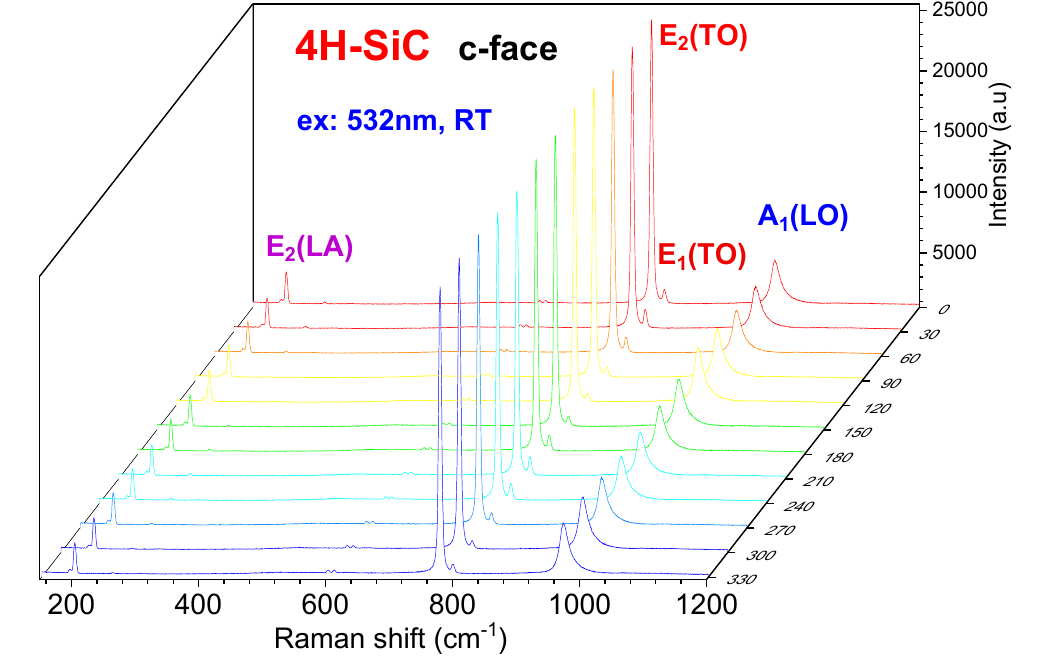
Figure 2. The angle-dependent Raman spectra of the c-face 4H-SiC, at different rotation angles of 0–330°, were measured at RT with the excitation of 532 nm.